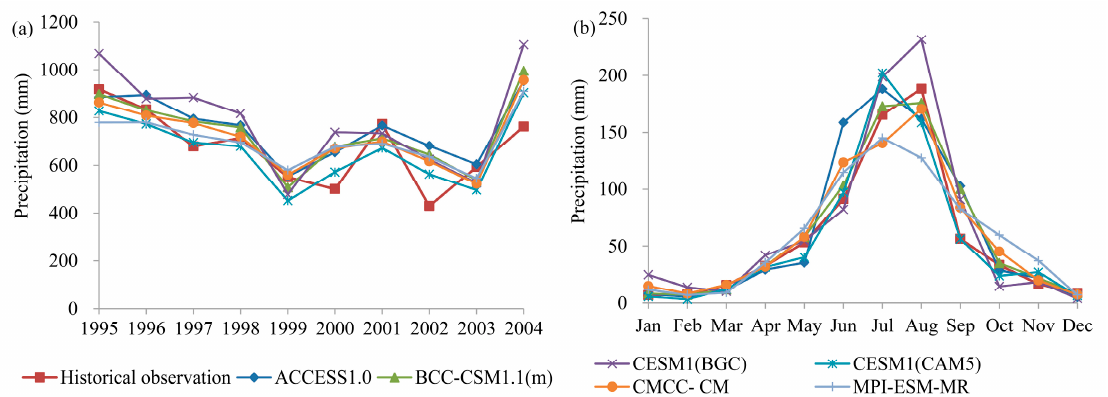
Figure 8. Comparison of the downscaled precipitation from CMIP5 using morphing and historical observation precipitation series: ( a ) annual series; ( b ) monthly distribution.